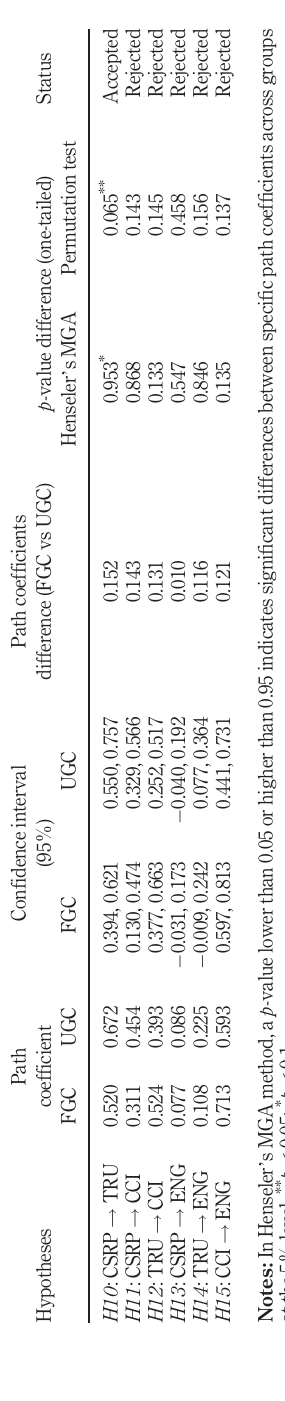
Table IX. Moderating effect